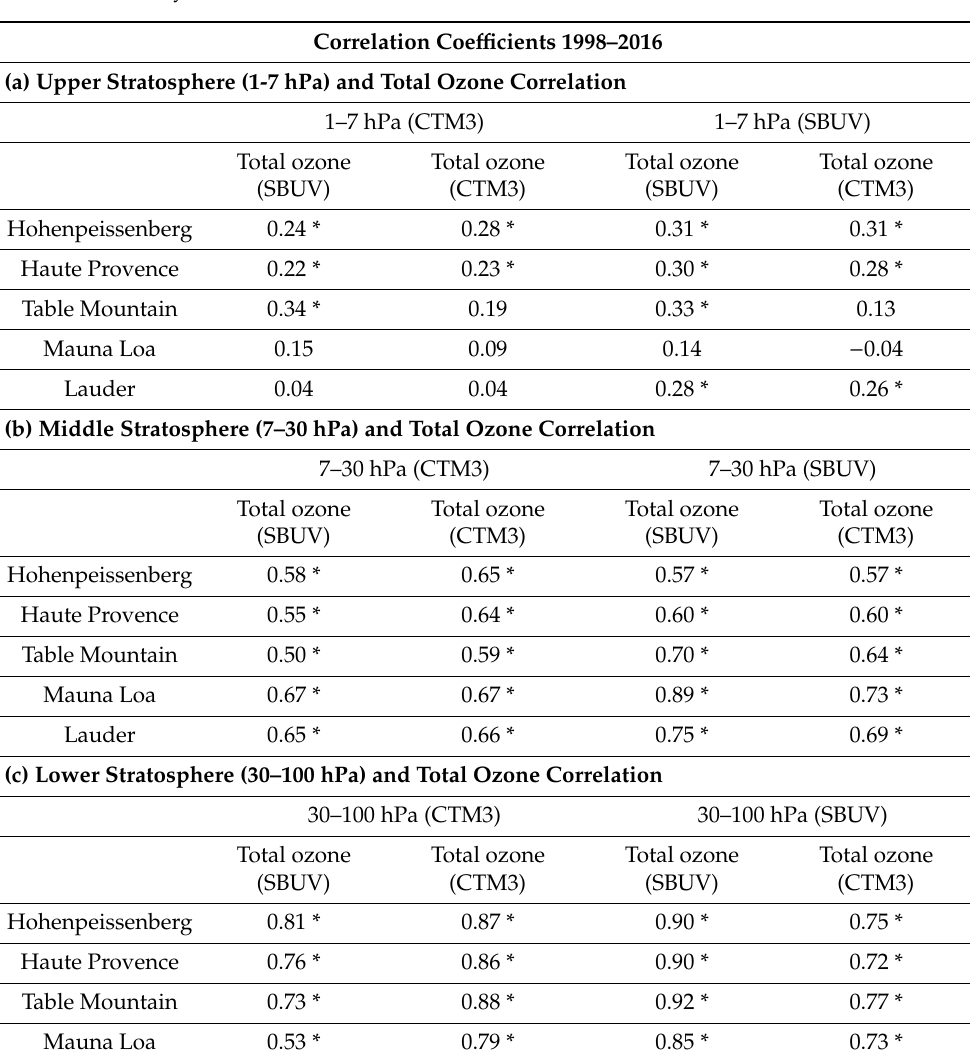
Table 5. Correlation coe ffi cients between layer-mean ozone and total ozone from model (Oslo CTM3) and satellite (SBUV v8.6) data in ( a ) the upper stratosphere, ( b ) middle stratosphere and ( c ) the lower stratosphere at 5 lidar stations, after removing seasonal and known natural variability. Significance at 99.9% is denoted by